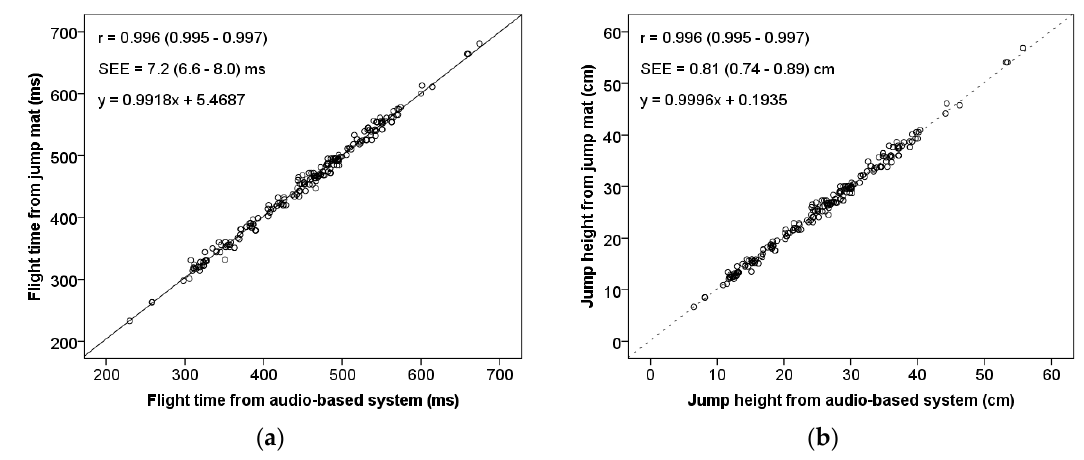
Figure 7. Relationship between measurements derived from jump mat system and audio-based system. ( a ) Flight time; ( b ) Jump height. Pearson’s product moment correlation coefficient ( r ) and standard error of estimate (SEE) shown with a 95% confidence interval between brackets; p < 0.01.